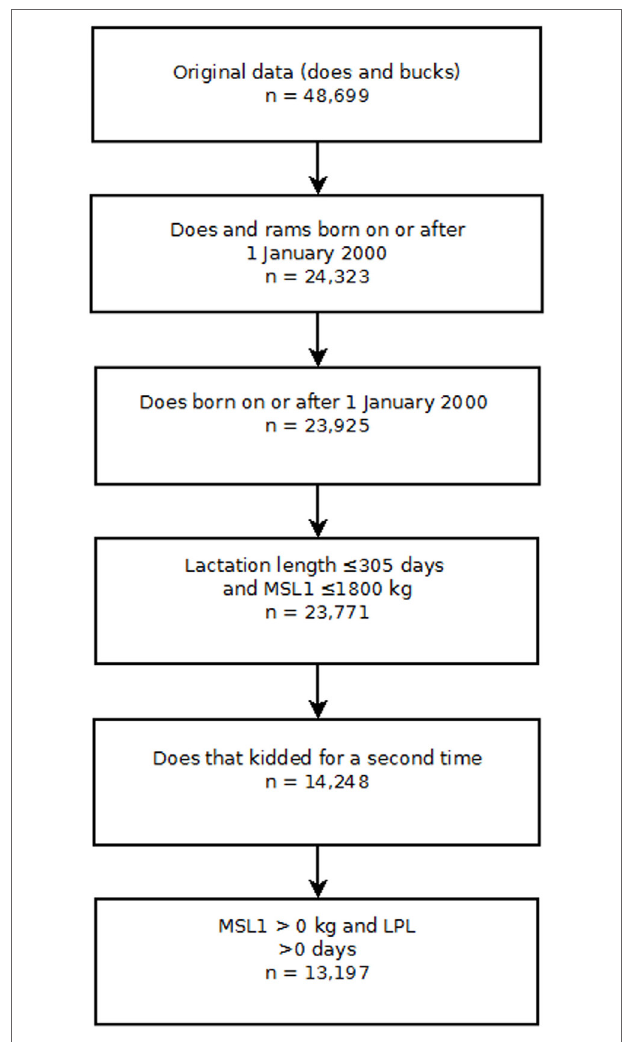
FigUre 1 | Risk factors for culling, sales and deaths in New Zealand dairy goat herds, 2000–2009. Flow chart showing the exclusion criteria used to select individual doe records for analysis in this study. Key: MSL1 first lactation milk solids yield (kilograms); LPL, length of productive